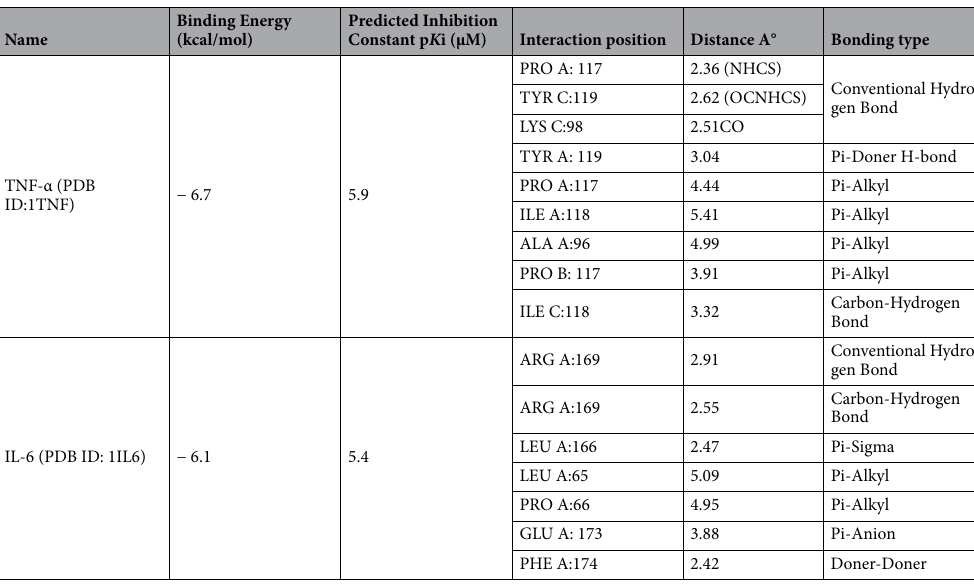
Table 3. Molecular docking of